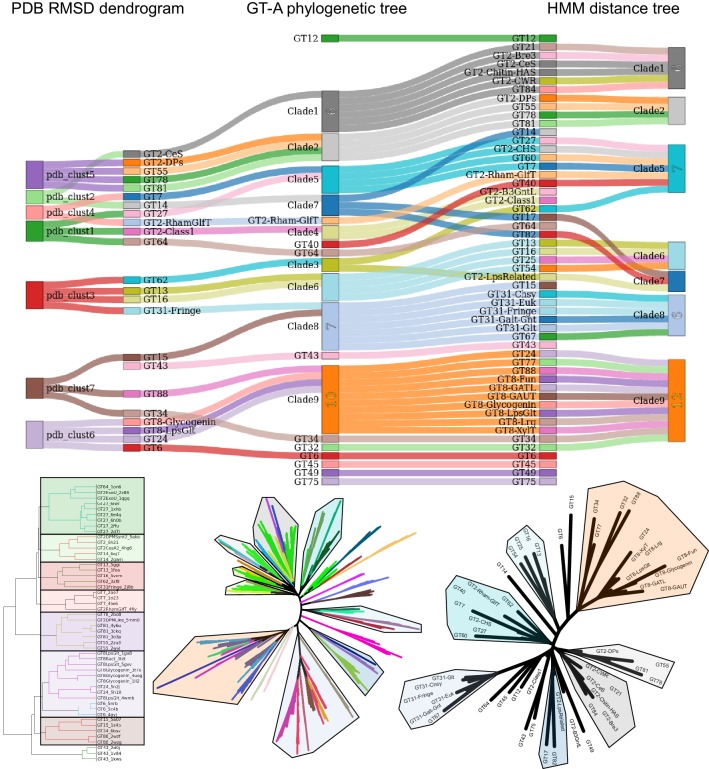
Sankey diagram comparing topologies of phylogenetic tree with pdb and hmm based clustering of GT-A families.Each column highlights clusters of GT-A families obtained through different methods (from left to right: PDB structural alignment clustering, GT-A phylogeny and hmm-distance based tree). Corresponding GT-A families within clusters are connected through colored links. Non overlapping links indicate an agreement in the placement of families across methods. Full clusters and trees are shown below the columns.